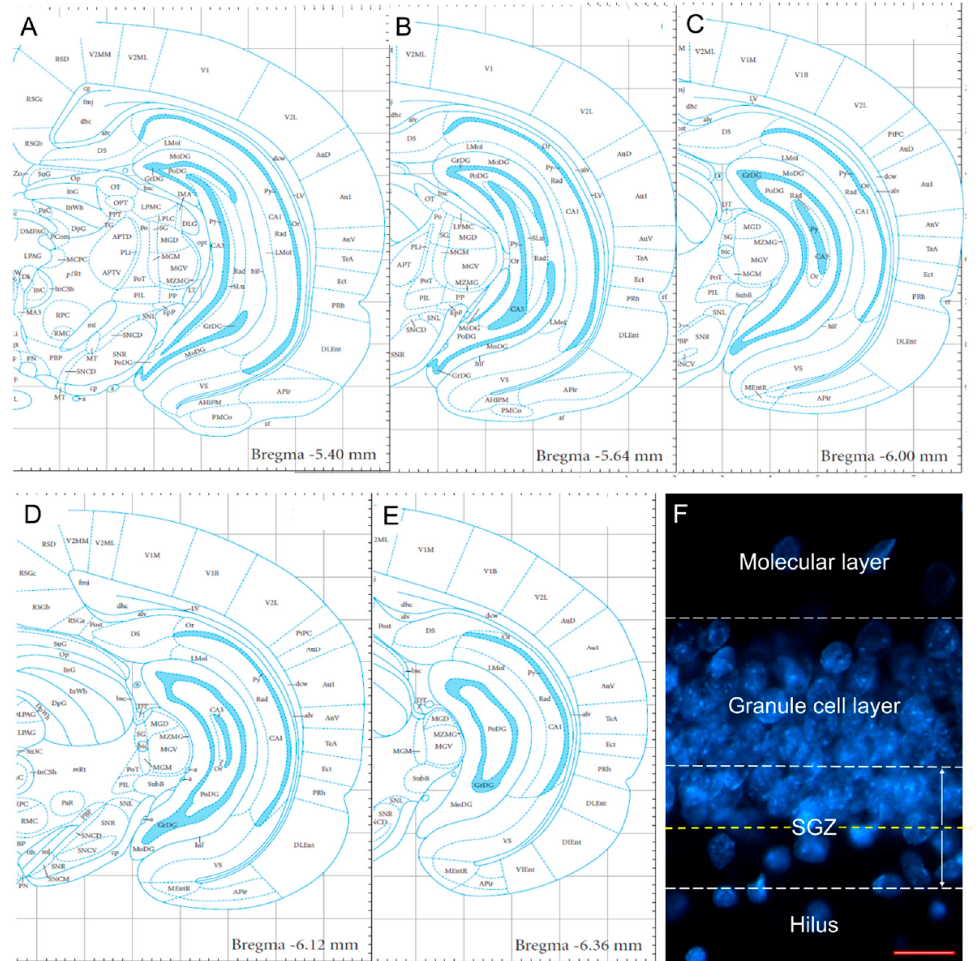
Figure 13. Ventral hippocampus and its subregions implicated in the study. ( A – E ) Schemes showing representative coronal slices of the ventral hippocampus along the rostro caudal axis; the antero- posterior coordinates are shown in the inferior part of each scheme. Moreover, the granule cell (GrDG), molecular (MoDG) and polymorphic (PoDG, also called hilus) layers of the dentate gyrus are indicated in each scheme (schemes modified from Paxinos and Watson, 2007 [49]). ( F ) Representative photomicrography evidencing the limits between molecular layer, granule cell layer, subgranular zone (SGZ) and hilus of the dentate gyrus. The granule cell layer was defined as the region constituted by the cell bodies of the granular neurons, the molecular layer refers to the area located above of the granule cell layer, and the SGZ was considered as the area occupied by two cell bodies, pointing both up and down (white dotted lines), from the inferior edge (yellow dotted line) of the granule cell layer. Scale bar (red): 20 µm.